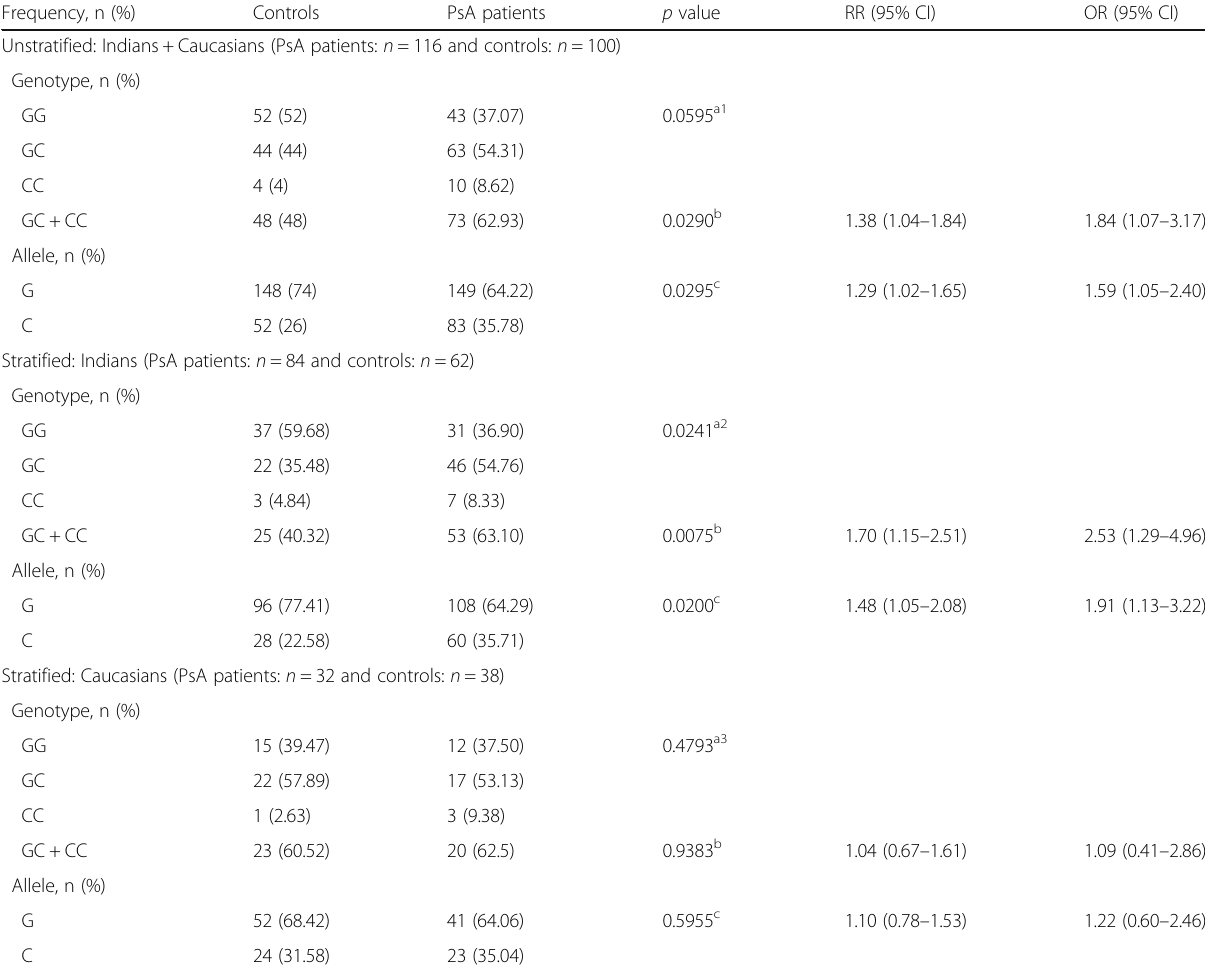
Table 3 Genotype and allele frequencies for PsA patients and controls before and after stratification for race (Indians and Caucasians) Frequency, n (%) Controls PsA